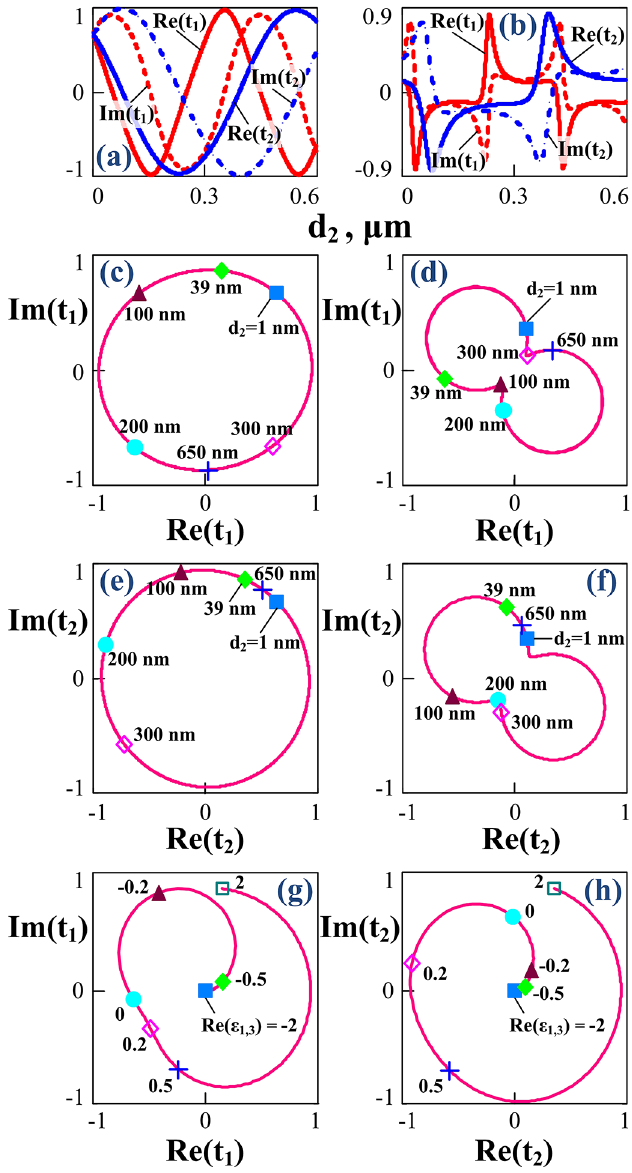
Fig. 3. The effect of parameter d 2 on the real and imaginary parts of amplitude transmission coef fi cients of waves 1, 2 (a, b) and trajectories of the tips of vectors t 1,2 on the complex plane depending on parameters d 2 (c – f) and e 0 (g,h). The values of 1 ; 3 parameters are: e 1 = e 3 =2 +10 (cid:1) 3 i (a, c, e); e 1 = e 3 =0.01 +0.01 i ¼ 10 (cid:1) 3 , d (b, d, f); e 00 2 =39 nm (g, h). The values of parameters 1 ; 3 for all the graphs are: d 1,3 = 0.25 m m, l =0.63 m